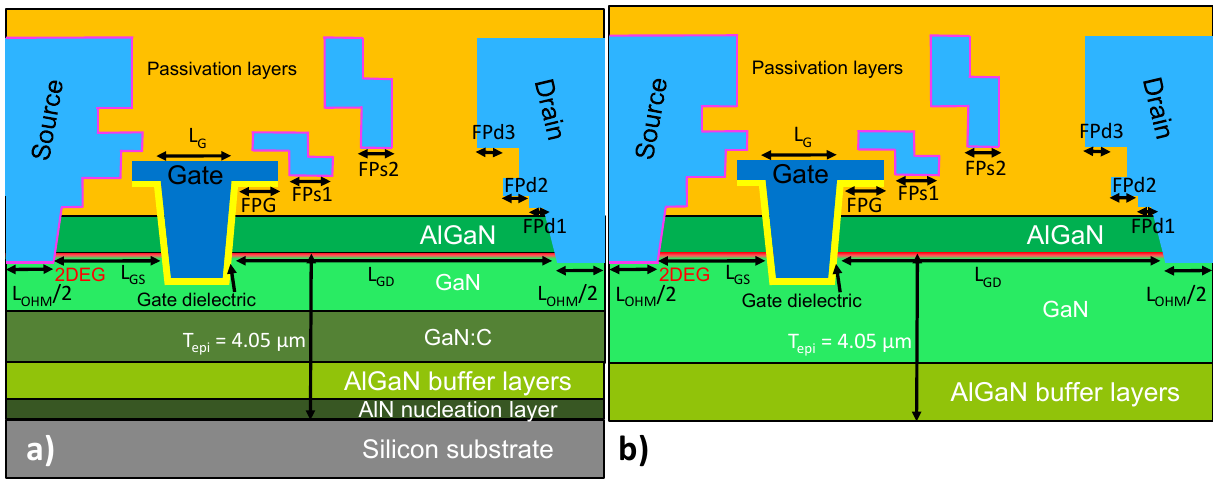
Figure 1. Transistor detailed cross ‐ section in ( a ) the experiments ( b ) the TCAD simulation.